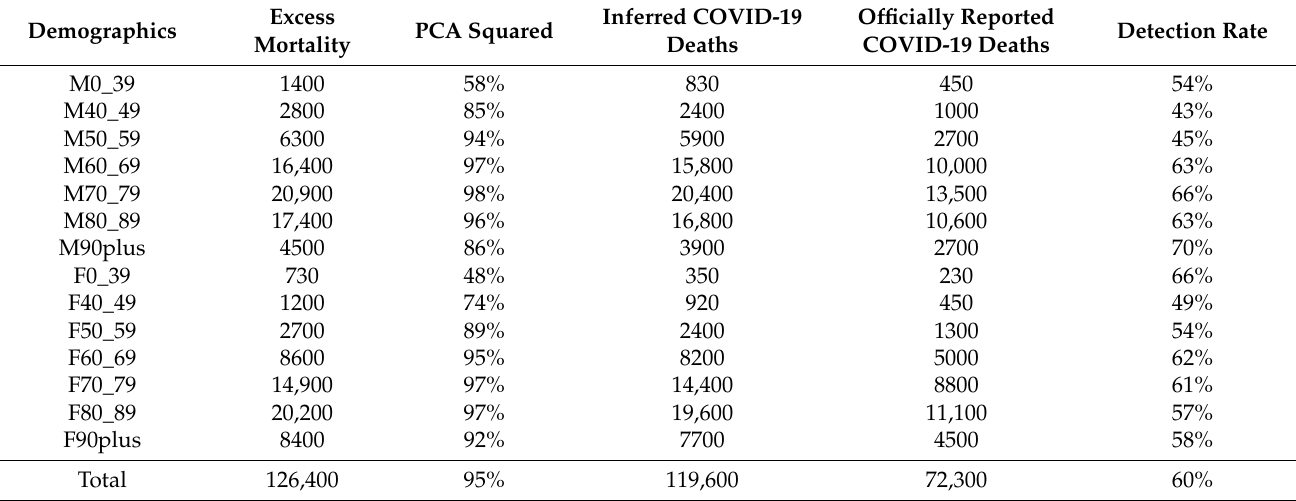
Table 1. Comparison of excess mortality, COVID-19 deaths calculated on the basis of our model, and officially reported COVID-19 deaths by demographic groups. Data source — officially reported deaths: Statistics Poland, Polish Chief Sanitary Inspector, inferred deaths: own calculation.